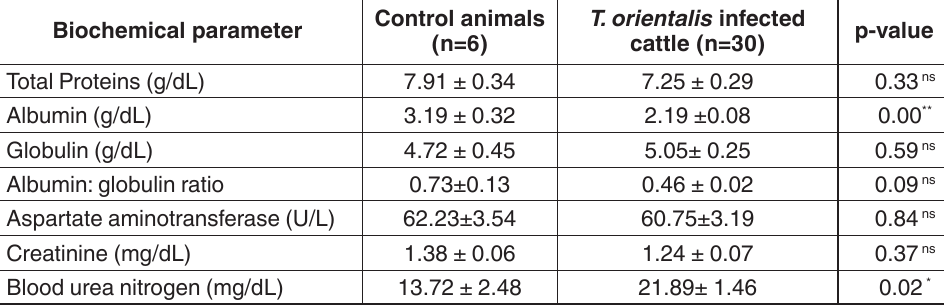
table 2. Comparison of biochemical parameters between control animals and T. orientalis infected cattle Biochemical